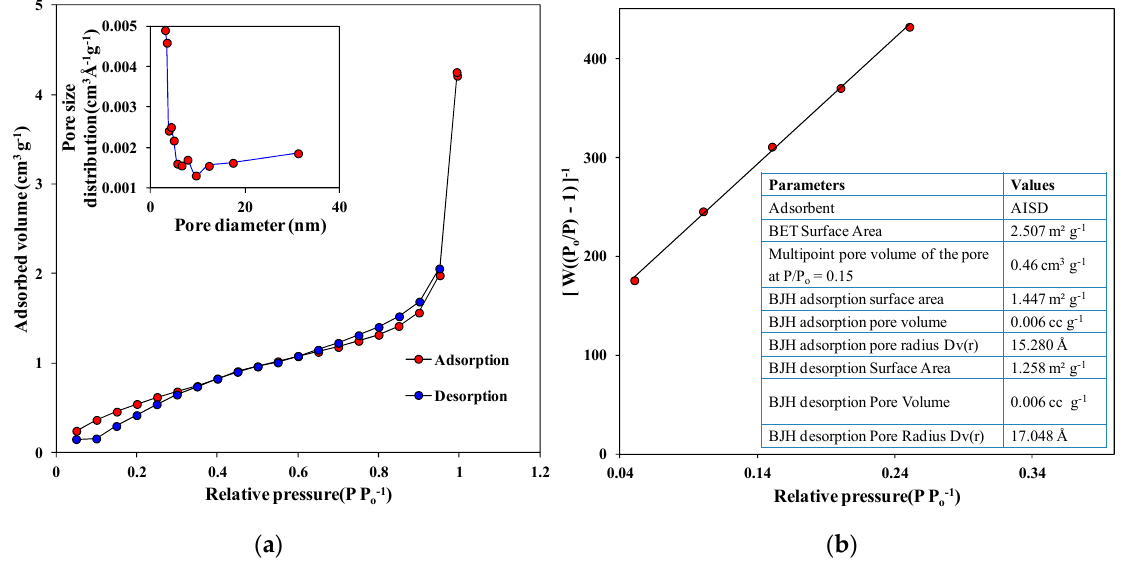
Figure 3. ( a ) BET nitrogen adsorption − desorption isotherm (inset − BJH pore size distribution vs. pore diameter plot) for AISD and ( b ) multipoint BET plot for AISD.